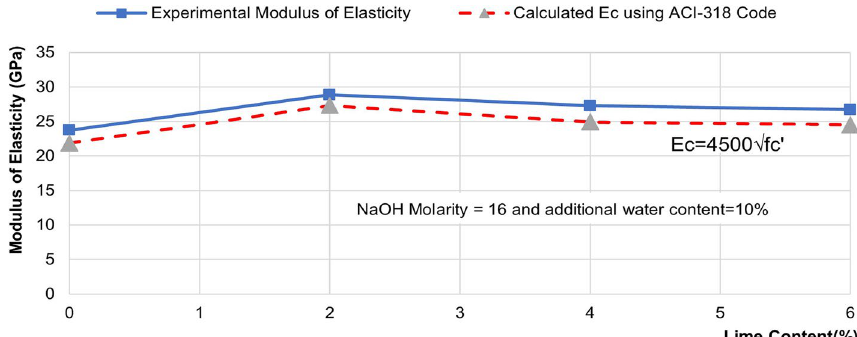
Fig. 6 The relation between lime content and concrete modulus of elasticity for NaOH molarity of 16 and additional water content of 10% compared with the modulus of elasticity equation of ACI-318 code for ordinary concrete